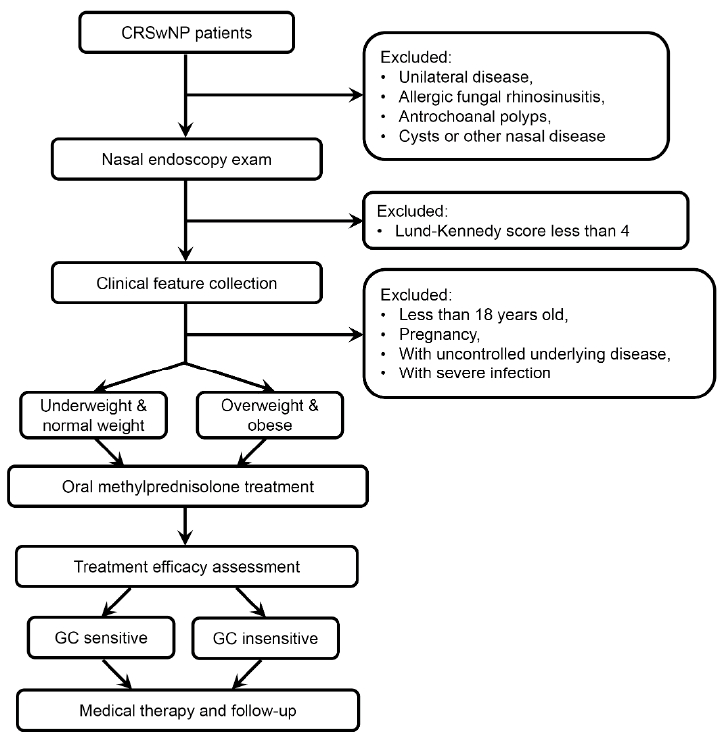
Figure 1. The flow chart of the study design.